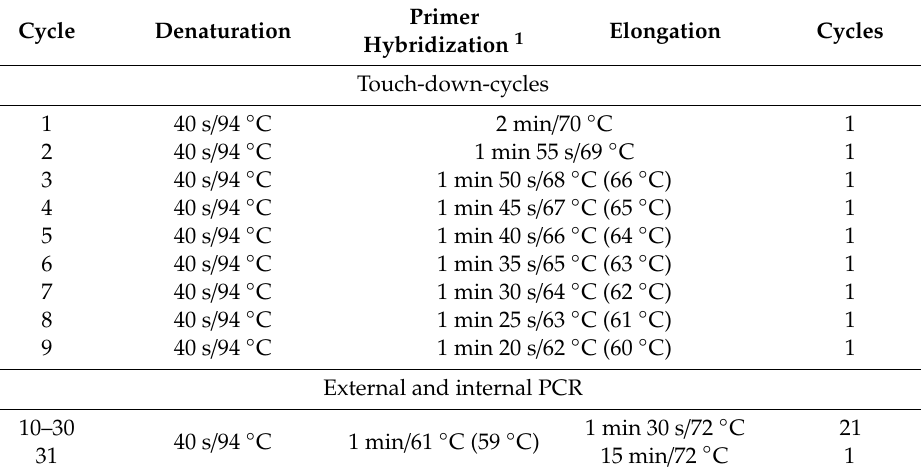
1 : temperatures in parentheses were used for the PBGD